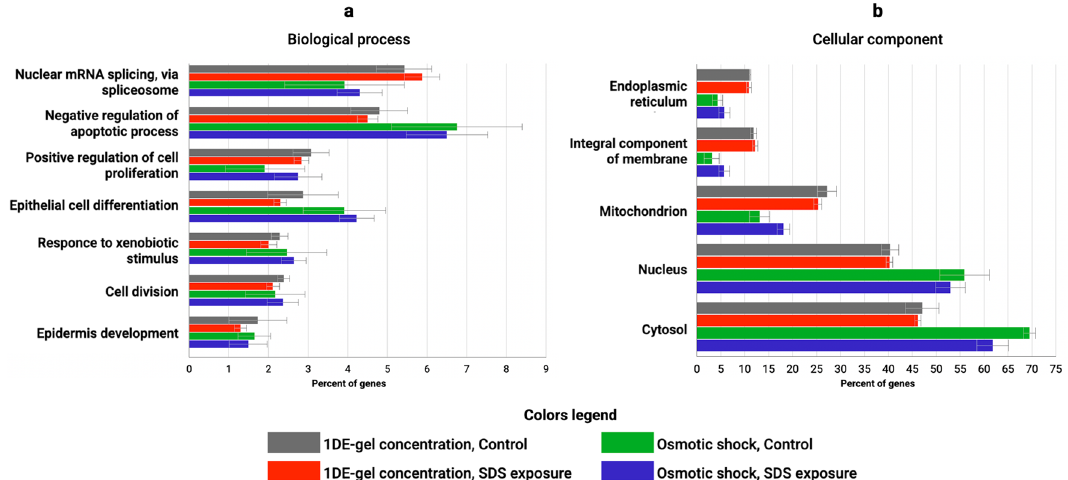
Figure 4. GO enrichment analysis of the proteins identified by ≥ 2 unique validated peptides in ( a ) biological process and ( b ) cellular component. Error bars represent the standard